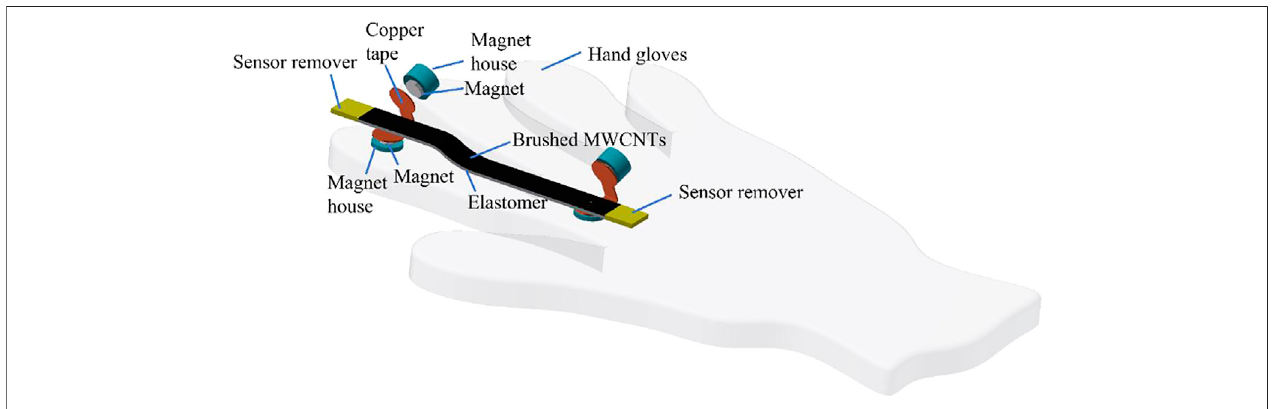
FIGURE 6 | Plug-and-play concept of the stretchable strain sensor.